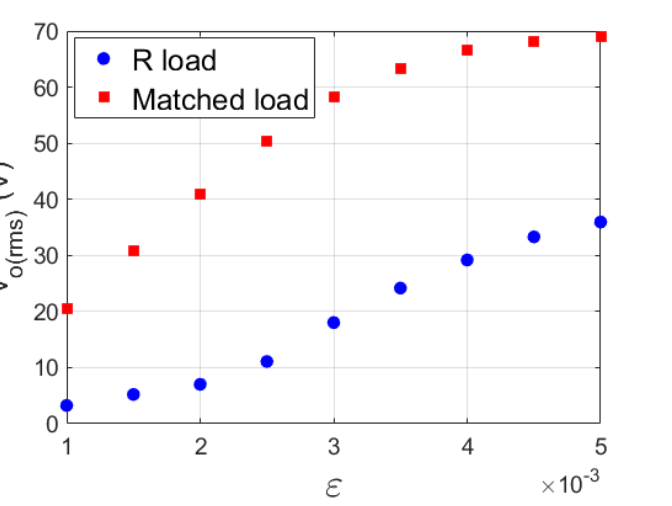
Figure 5. Root mean square of the output voltage as a function of the noise intensity. Blue circles: Resistive load. Red square: Matched load.